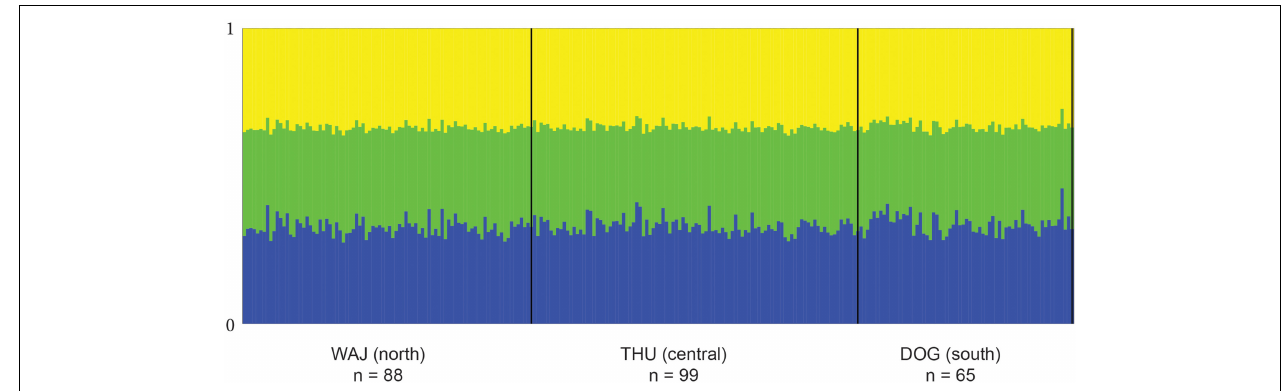
FIGURE 1 | Averaged bar plot graph of STRUCTURE results for K = 3. Each vertical line of the x-axis represents a single individual. The two bold vertical lines divide the sampling sites WAJ (north), THU (central), and DOG (south) with numbers of